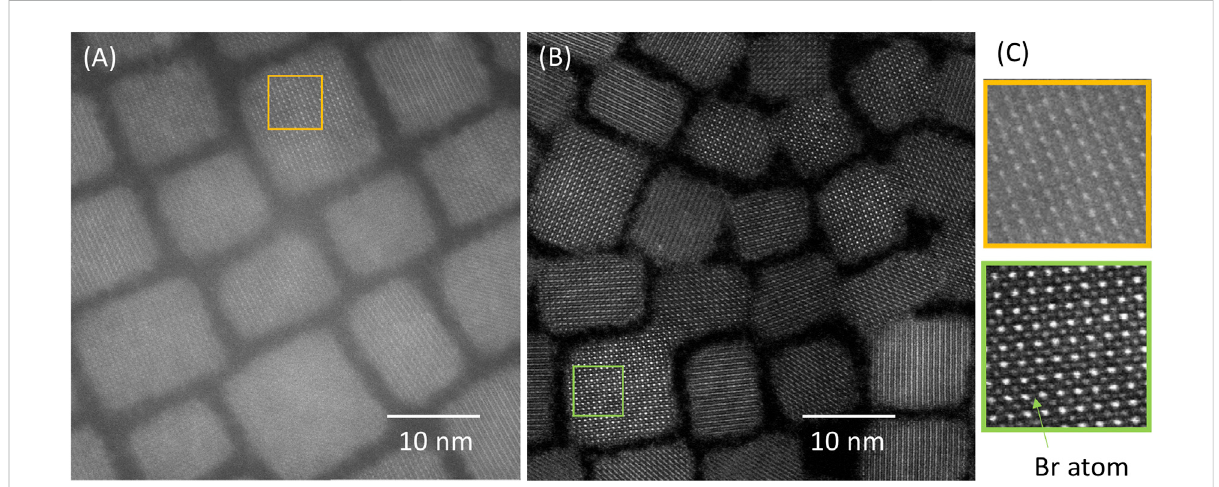
FIGURE 1 High-angle annular dark fi eld (HAADF) scanning transmission electron microscopy (STEM) image of CsPbBr 3 nanocrystals (A) on a commercial carbon fi lm and (B) on transferred graphene support with the same pre-treatment for cleaning before introduction into the microscope column. (C) Magni fi ed view of the boxed areas in (A) and (B)